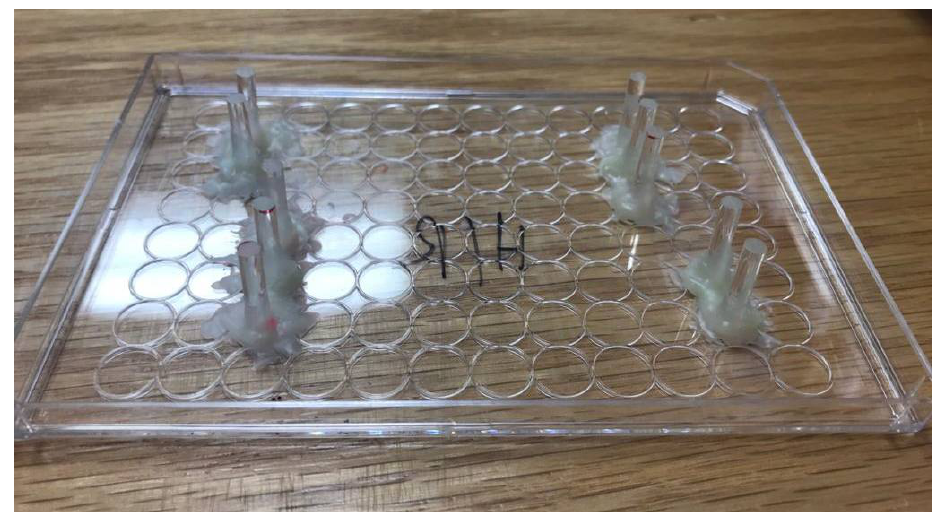
Figure 3. Image of the compression device. Plastic rods with 16 mm length and 3.175 mm diameter were fixed onto a lid of a 96-well plate.